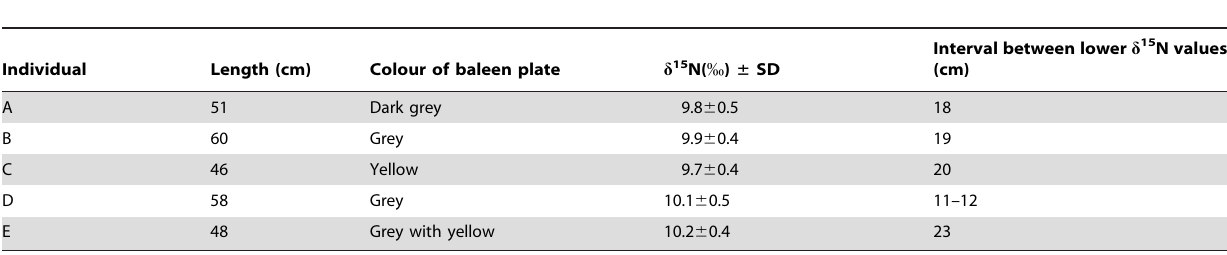
Table 2. Characteristics and d 15 N values of the baleen plates used in the analysis.